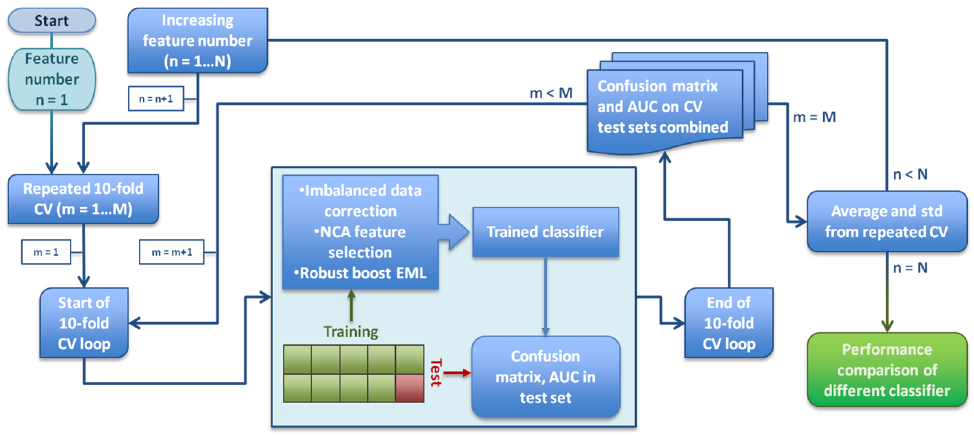
Figure 3. Model building and validation scheme. A repeated 10-fold cross-validation (CV) was performed to yield accuracy and area under curve with standard deviations in order to make model comparisons.